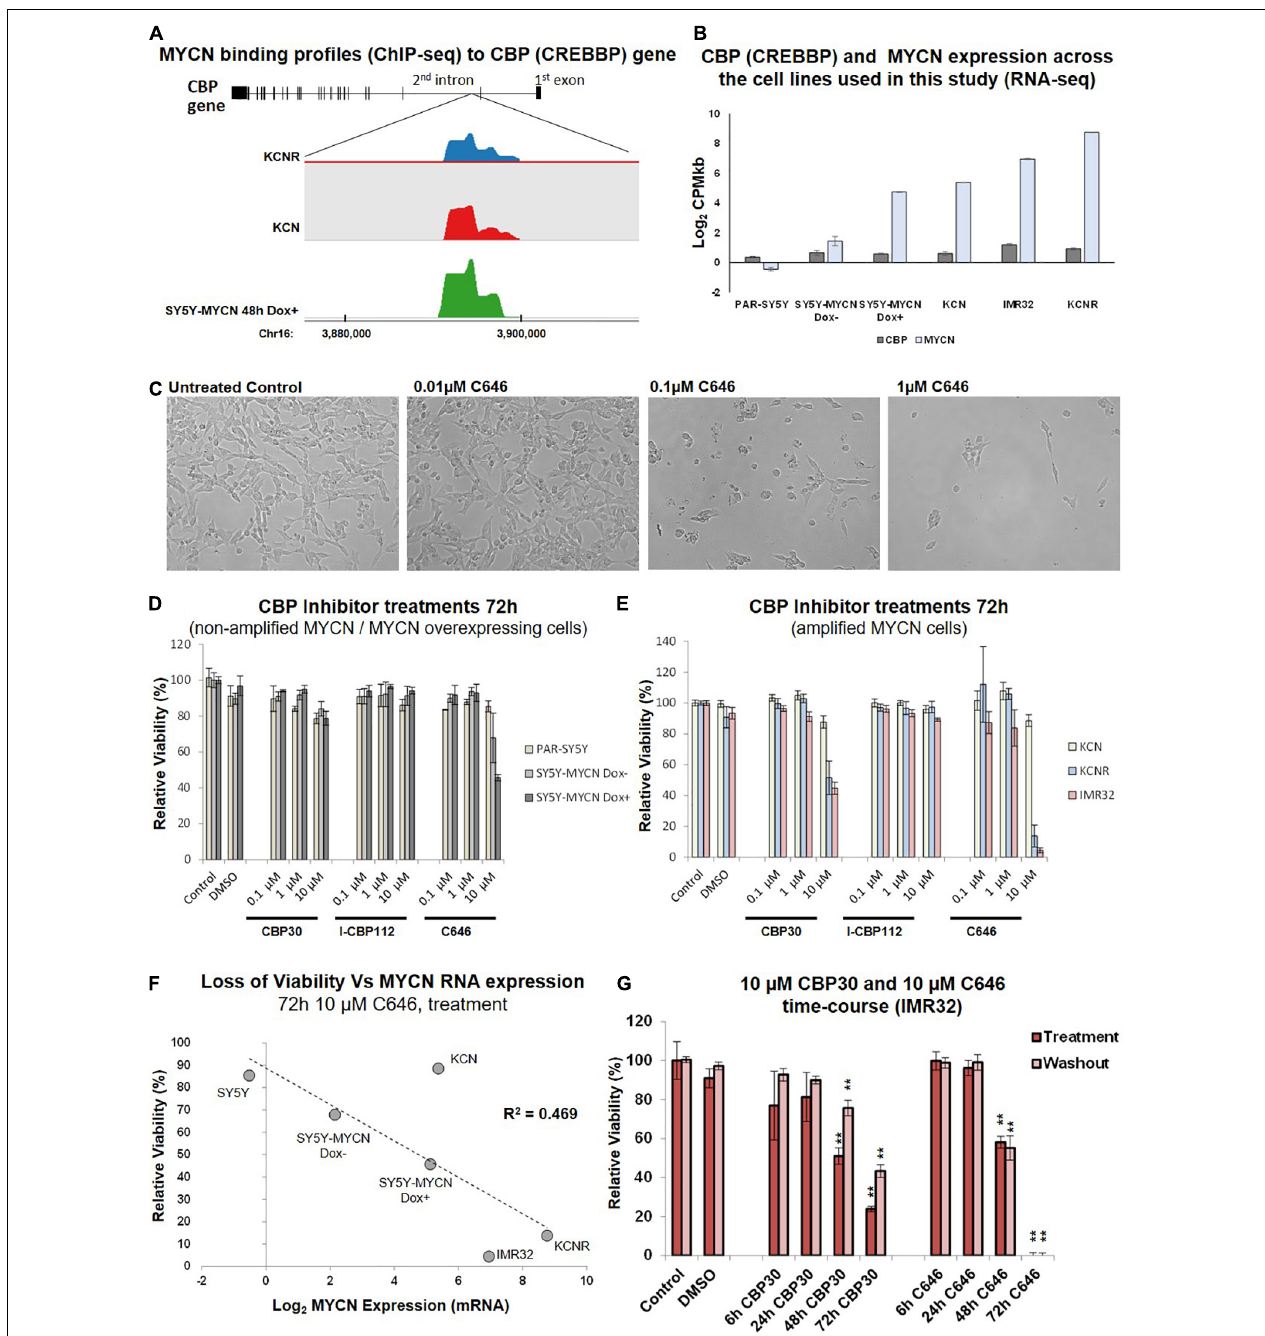
FIGURE 3 | CBP inhibition across a neuroblastoma cell line panel. (A) MYCN binding enrichment within the second intron of the CBP gene. Top – CBP gene schematic representation. Middle – Probe enrichment visualisation for KCNR, KCN, and SY5Y-MYCN 48 h Dox induced representative datasets using the SeqMonk tool. Bottom -genomic coordinates. (B) CBP and MYCN transcript expression levels across the cell line panel. Read counts per million adjusted by gene length in kilobases (CPMkb), obtained from our previously published RNA-seq of these cell lines (Duffy et al., 2015, 2017). (C) Images of IMR32 cells after 48 h treatment with C646. Images were taken with 40x magnification. (D) Relative viability (Alamar Blue assay) upon CBP inhibitor treatment (CBP30, I-CBP112 and C646) of MYCN single copy cell lines, including doxycycline inducible MYCN cell line SY5Y-MYCN. (E) Relative viability (Alamar Blue assay) upon CBP inhibitor treatment (CBP30, I-CBP112 and C646) of MYCN amplified cell lines, including doxycycline inducible MYCN cell line SY5Y-MYCN. (F) Correlation of relative viability loss upon C646 treatment (Alamar Blue assay) and MYCN mRNA expression (Log 2 fold change) obtained from RNA-seq (Duffy et al., 2015). R 2 -value reported on the panel is from a Pearson Correlation Coefficient analysis. (G) Relative viability (Alamar Blue assay) of C646 time-course (6 h, 24 h, 48 h, and 72 h) treatment of MYCN amplified IMR32 cells. Viability results immediately after treatment (Treatment) and after an additional 48 h in the absence of C646 after treatment ended (Washout) are shown. Paired sample t-test values are designated with asterisks above bars. P ≤ 0.05 - *; P ≤ 0.01 - **. Error bars indicate the mean ± SD.